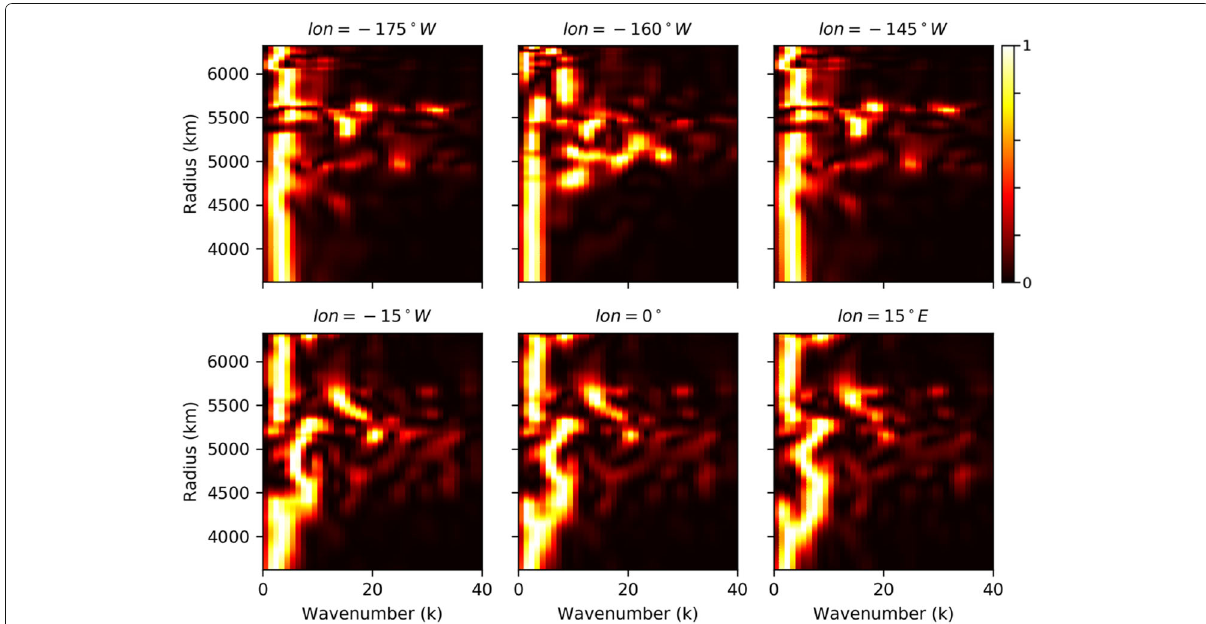
Fig. 7 Power spectral density plots for S40RTS over 30 ◦ longitude across the Pacific (top row) and African (bottom row) LLSVPs. Spectral power is normalized to the maximum power at each depth and plotted as a function of wavenumber and radius. Over 30 ◦ , the broad scale